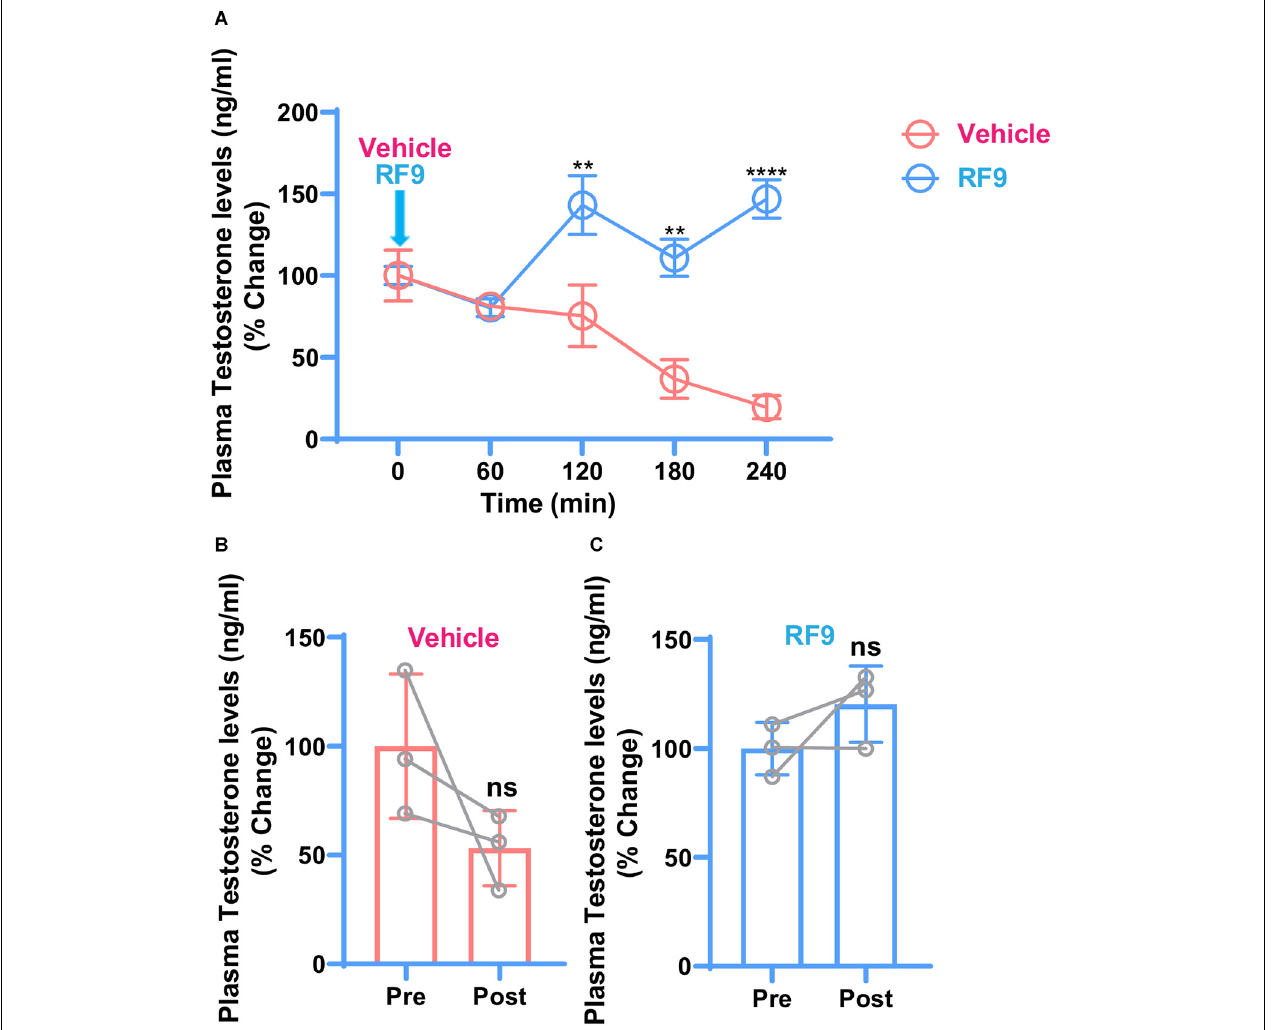
FIGURE 2 | Changes in mean ± SEM plasma testosterone concentration as reflected by % change with respect to 0-min concentration, before and after iv administration of RF9/vehicle (arrow) in hydrocortisone treated adult male rhesus monkeys ( n = 3). Two-way ANOVA with post hoc Bonferroni test showed a significant effect of treatment at 120 min (** P ≤ 0.0037), 180 min (** P ≤ 0.0016), and 240 min (**** P ≤ 0.0001) intervals (A) . Decreasing and increasing trend in post-treatment plasma testosterone levels were observed in vehicle (B) and RF9 (C) groups, respectively. It seems that because of the variations within groups, there is no significant difference in post-treatment testosterone levels in (B,C)